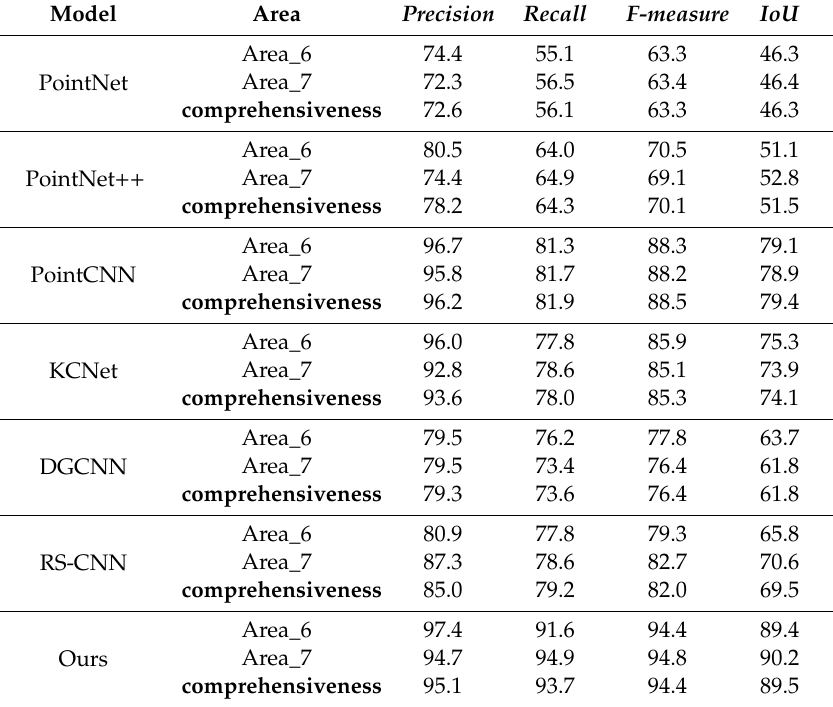
Table 5. Point-based building extraction comparison results on test